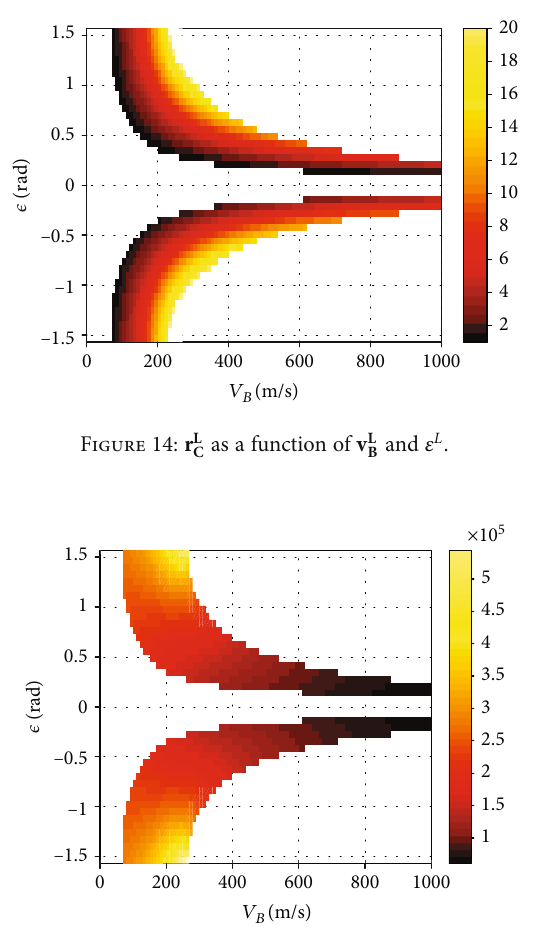
Figure 15: Δ t L as a function of v L